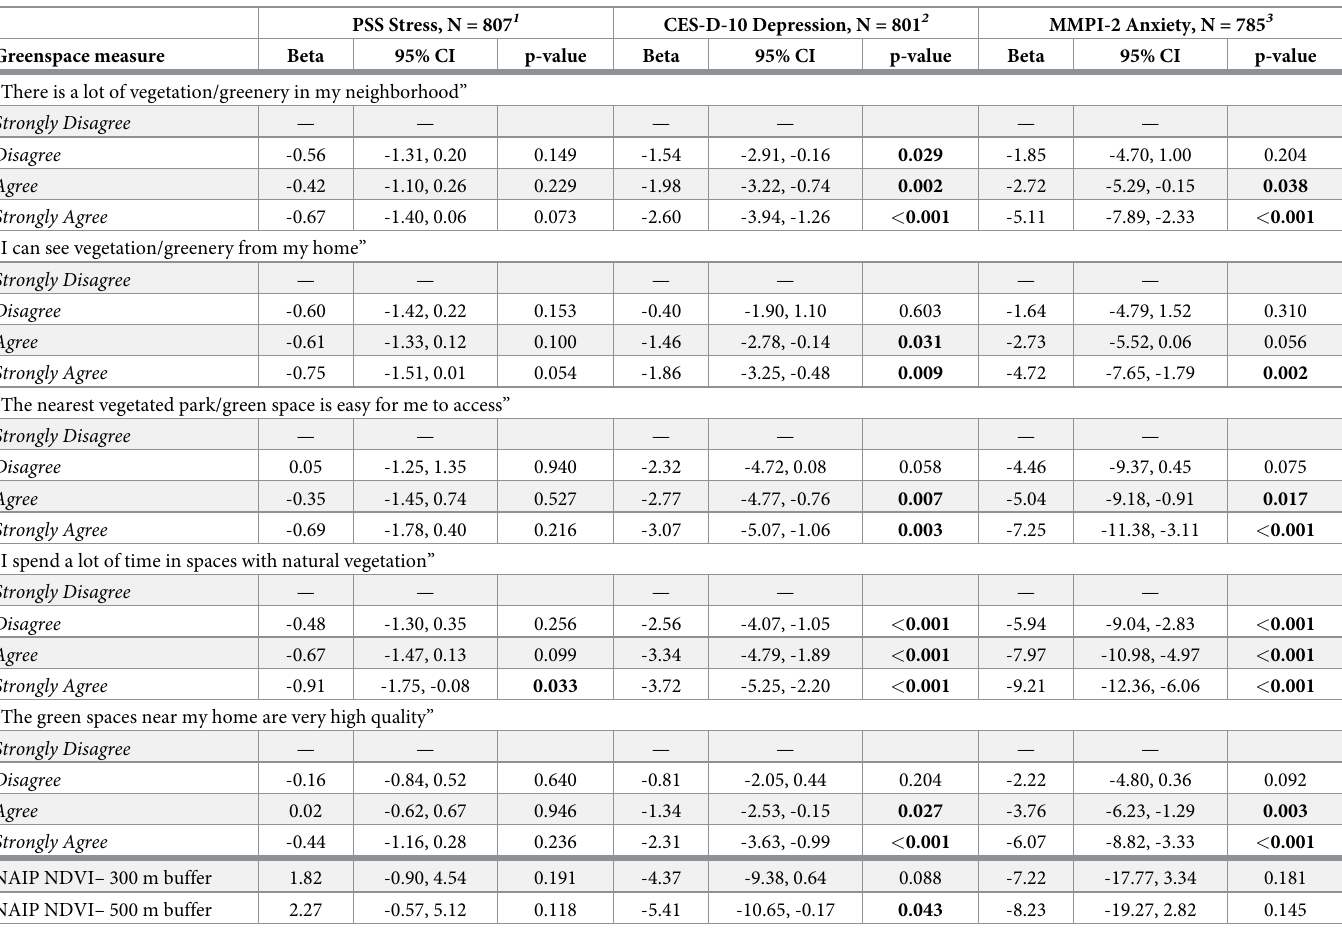
Table 3. Associations between psychological stress and distress and perceived and objective green space, adjusted for sociodemographic